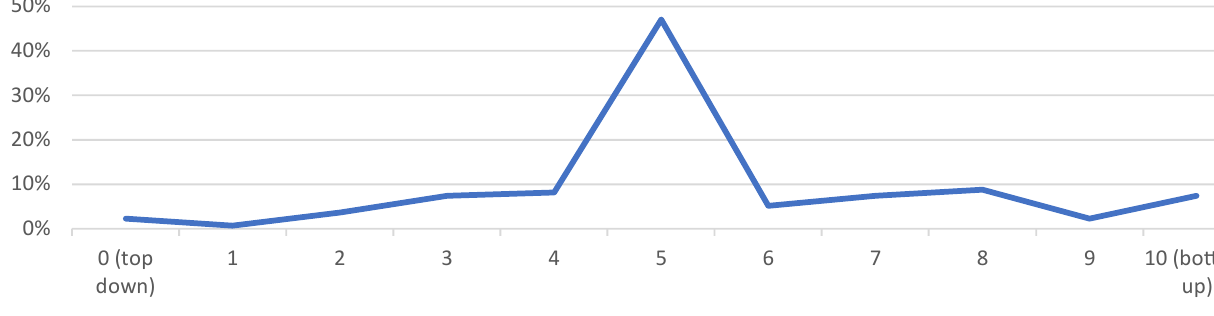
Figure 11. Perception of the need balance for community planning and design decisions.